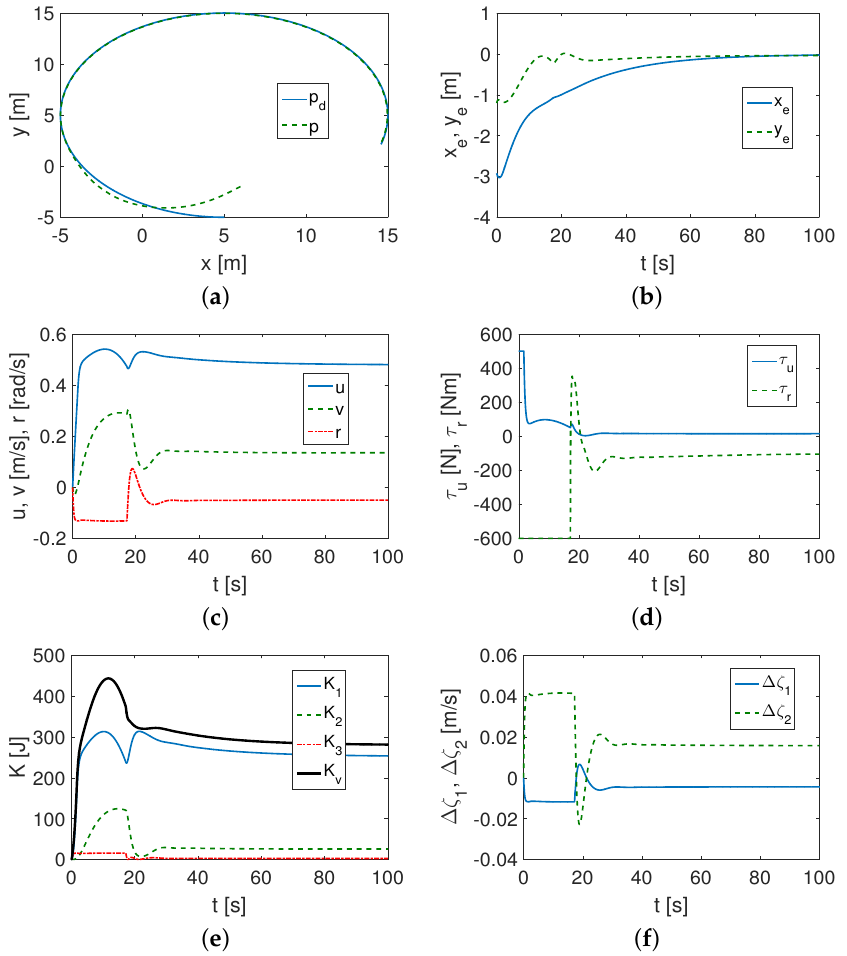
Figure 5. Results for the SIRENE, QV controller and partial circular trajectory: ( a ) desired and realized trajectory; ( b ) position errors; ( c ) velocity errors; ( d ) applied force and torque; ( e ) kinetic energy time history; ( f ) quasi-velocity errors ∆ ζ 1 , ∆ ζ 2